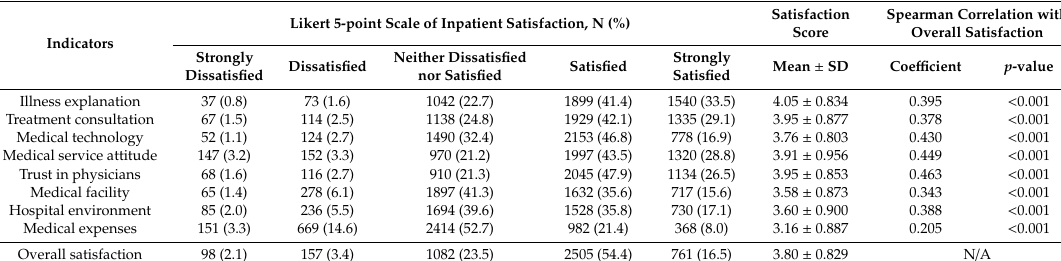
Table 3. Inpatient satisfaction with rural medical